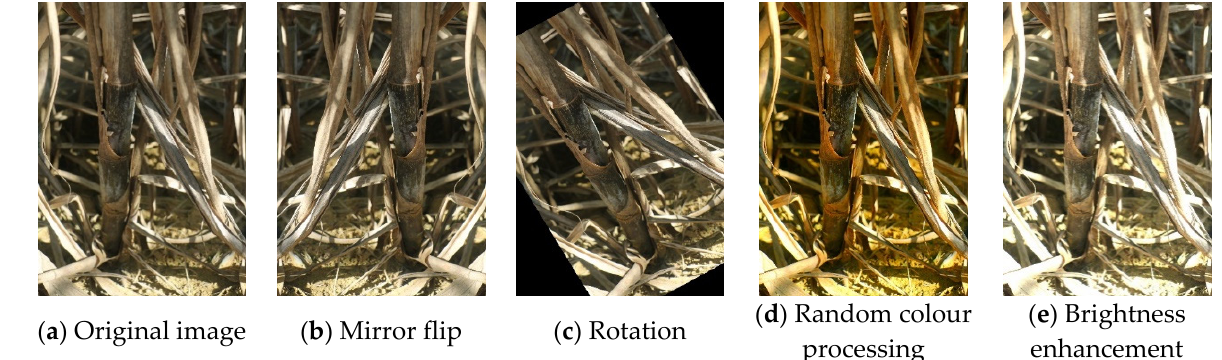
Figure 3. Image expansion methods.